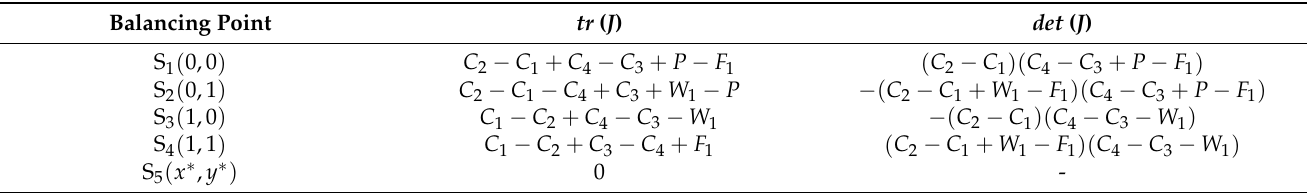
Table 4. Judgment basis for local stability of equilibrium points.